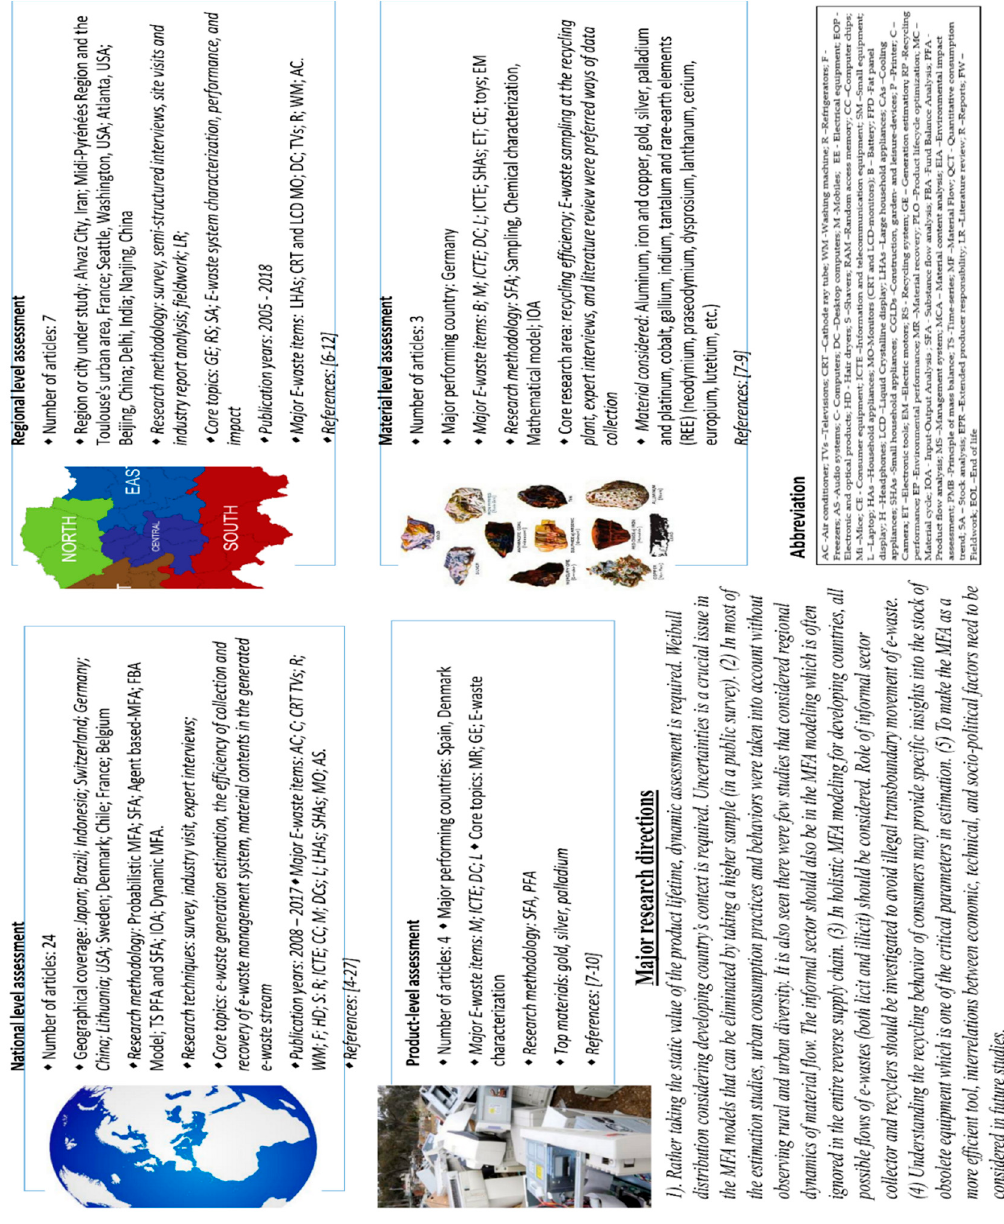
Figure 1. Detail mapping of MFA-E-waste research